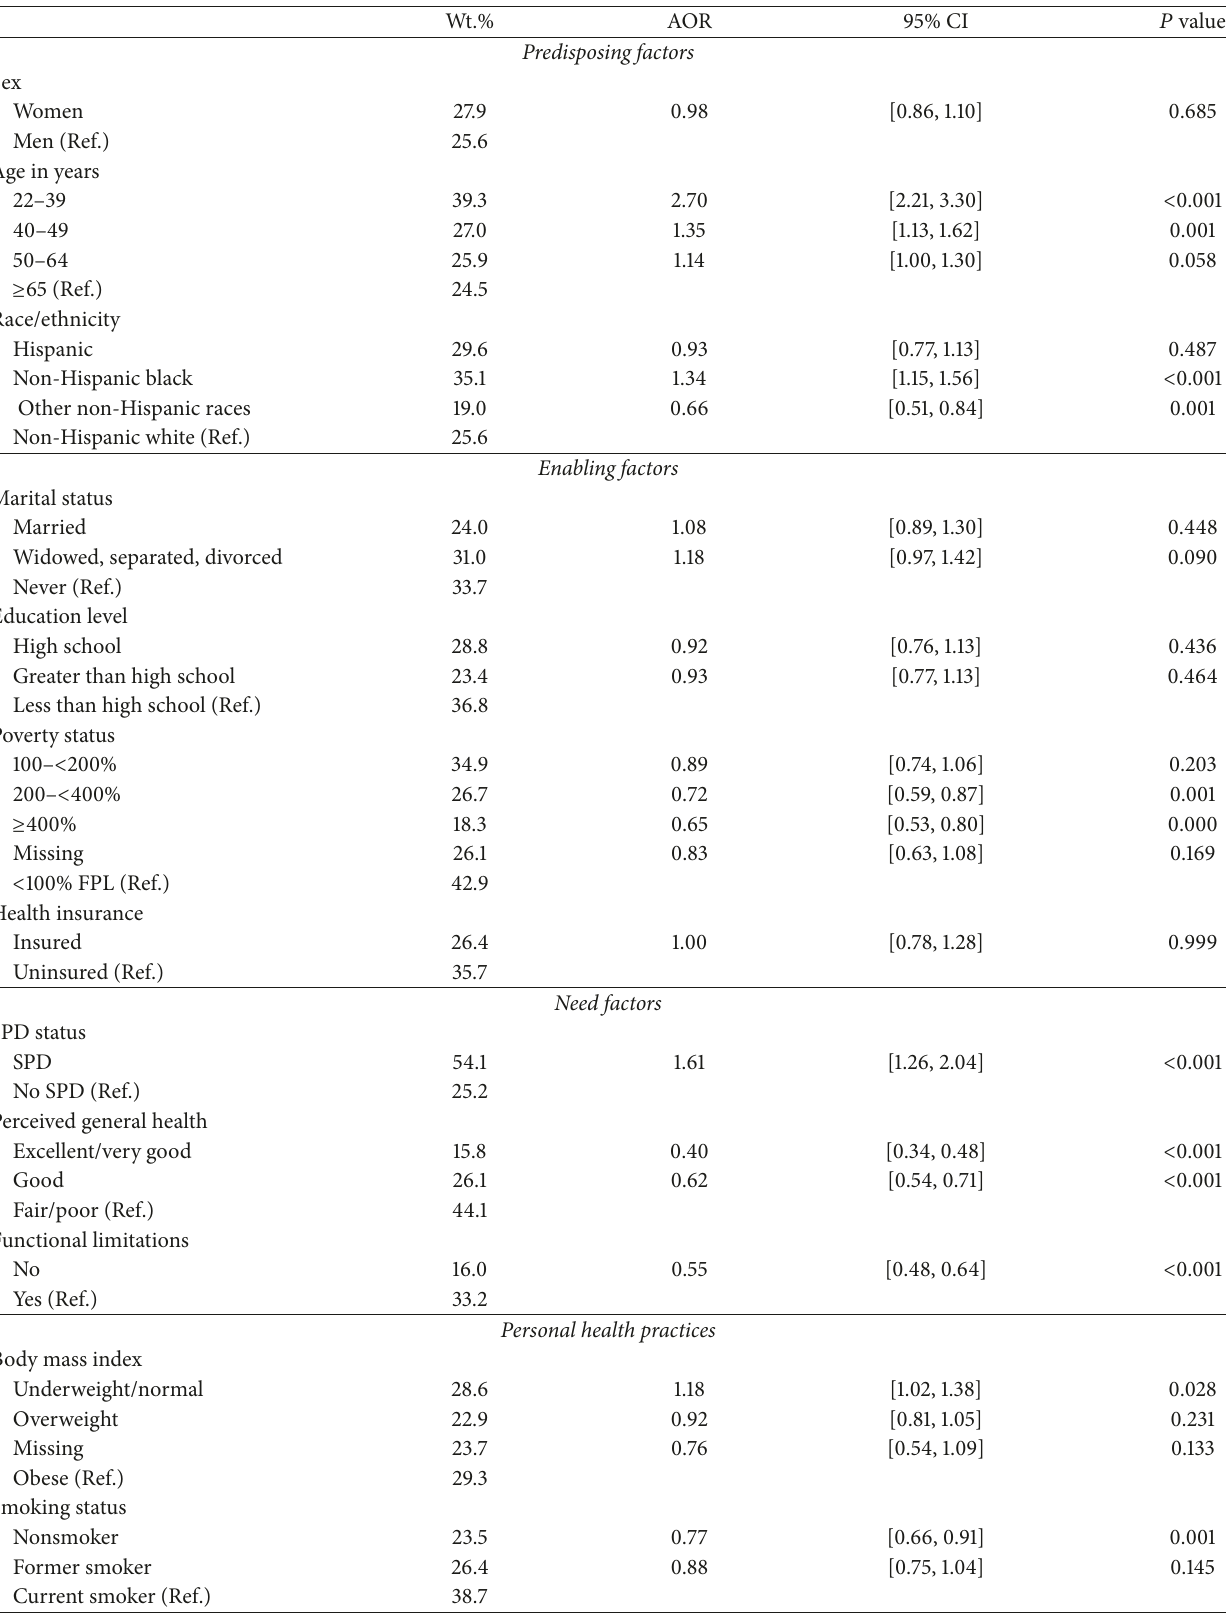
Table 2: Weighted row percentages, adjusted odds ratios, and 95% confidence intervals of serious psychological distress from logistic regressions on ER use in the past 12 months. National Health Interview Survey, 2015. Wt.%